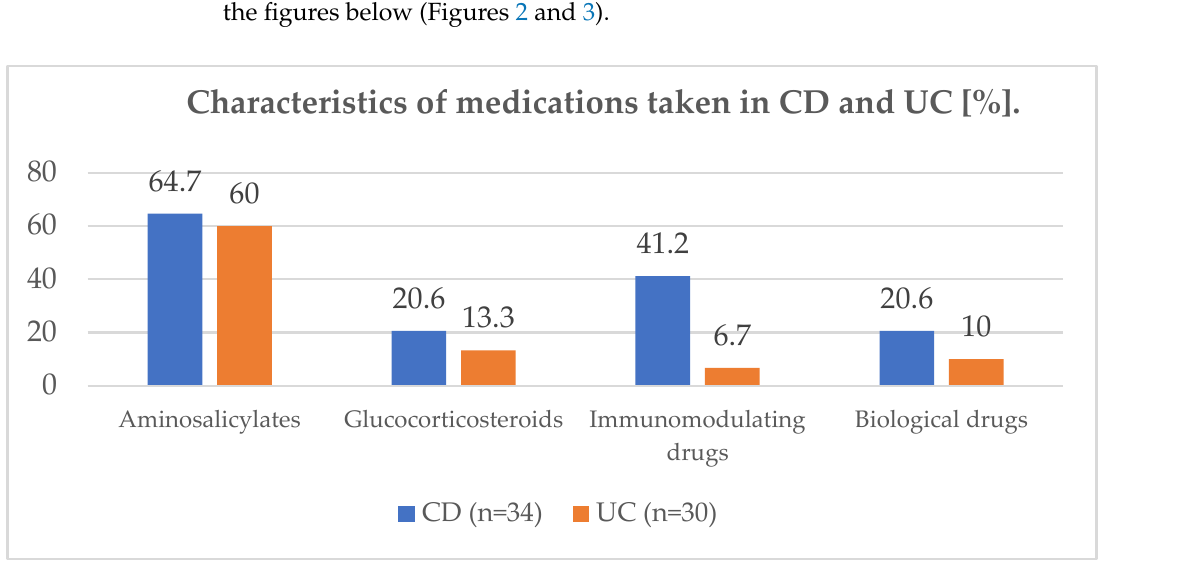
3 of 10 Figure 1. Characteristics of the study group (CD — Crohn ’ s disease, UC — ulcerative colitis). PCDAI —Pediatric Crohn’s Disease Activity Index; PUCAI — Pediatric Ulcerative Colitis Activity In- dex; GF — gluten-free diet, CDED — Crohn ’ s Disease Exclusion Diet; BMI — body mass index; IBD — inflammatory bowel disease. There were no statistical differences between the groups.